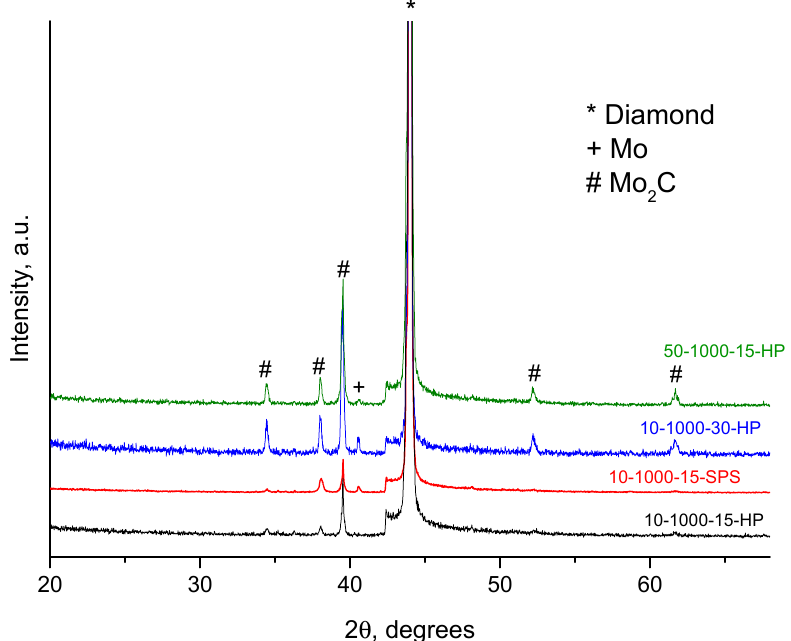
Figure 10. XRD patterns of the samples obtained at 1000 °C.